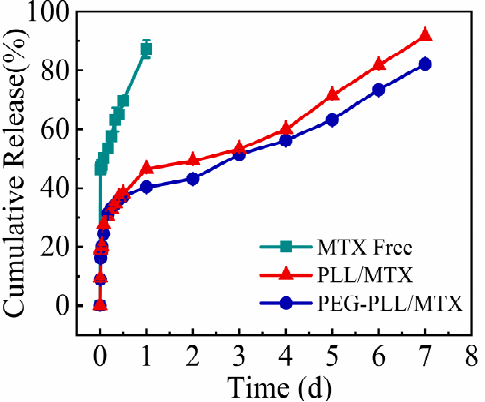
Figure 5. The cumulative release rate of MTX, PEG-PLL/MTX, and PLL/MTX in 5% glucose solution at 37 °C (n = 3).